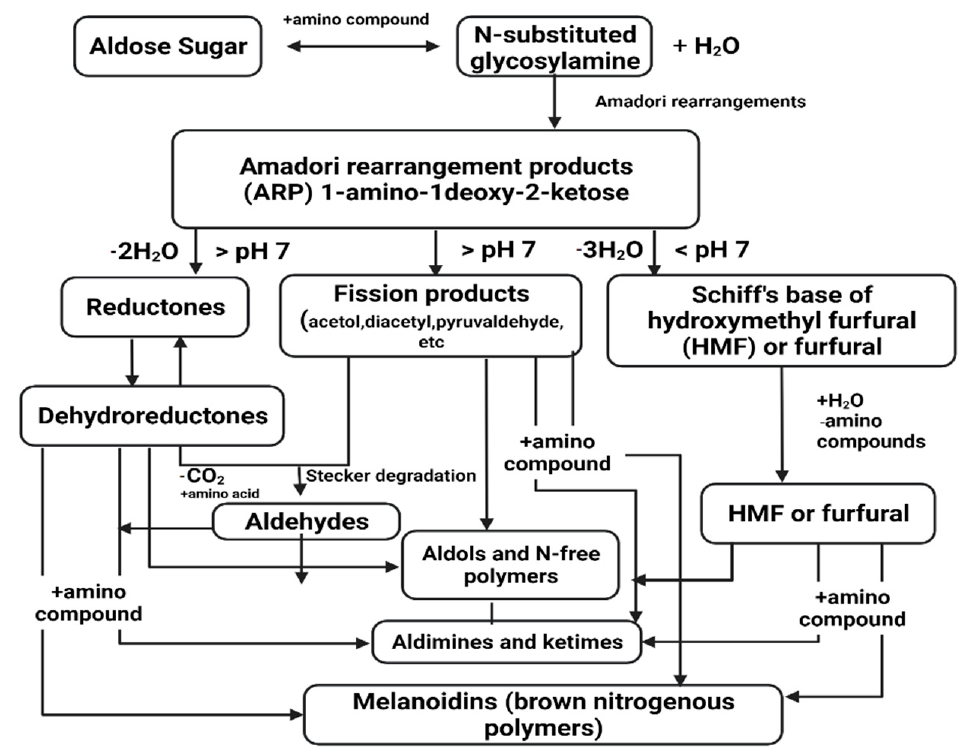
Figure 4. Scheme of Maillard reaction in different pH levels consisting of early stage with the formation of the ARP products and Schiff base, followed by the advanced stage, consisting of fission reaction, Stecker degradation, resulting in formation of advanced glycated products with a final stage of oxidation, condensation, cyclization, and rearrangement resulting in melanoidin polymers.